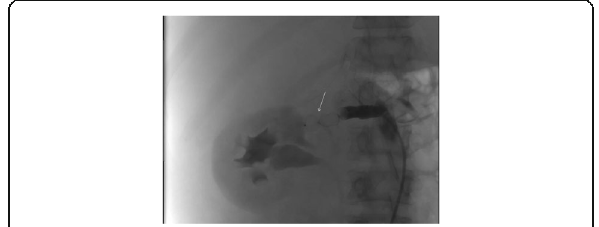
Fig. 3 AVF treatment. Subsequent treatment with the release of AVP IV (circle) at the corresponding afferent arterial branch and flow stop